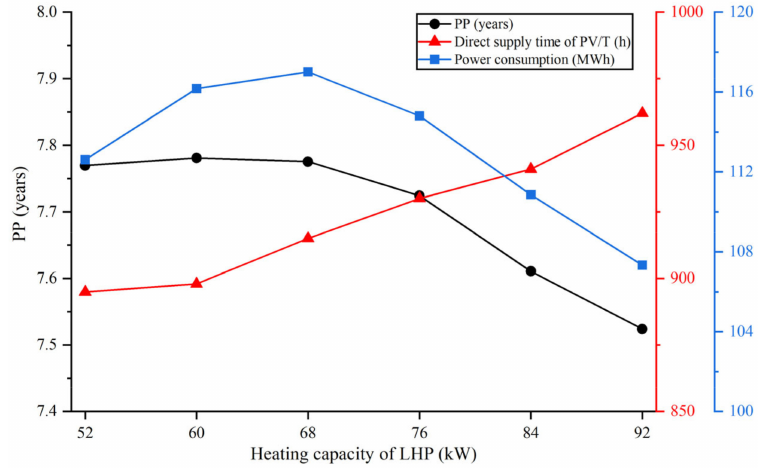
Figure 23. Variation between PP and direct supply time with different capacities of LHP.